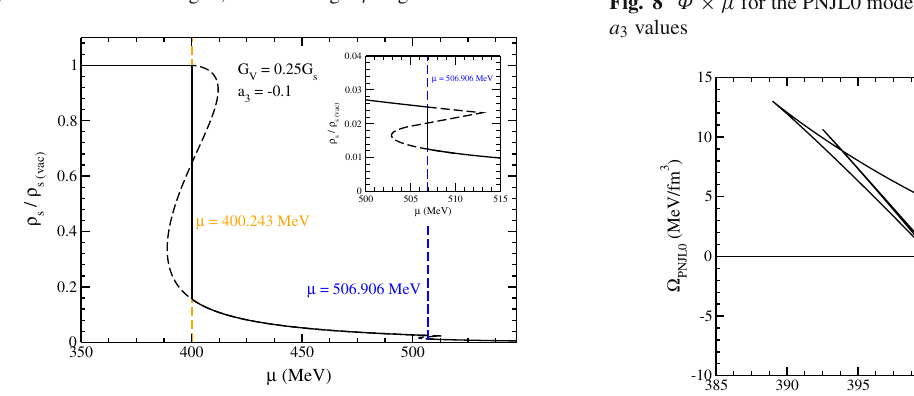
Fig. 7 Chiral condensate, in units of its vacuum value, as a function of μ for the PNJL0 model with G V = 0 . 25 G s and a 3 = − 0 . 1